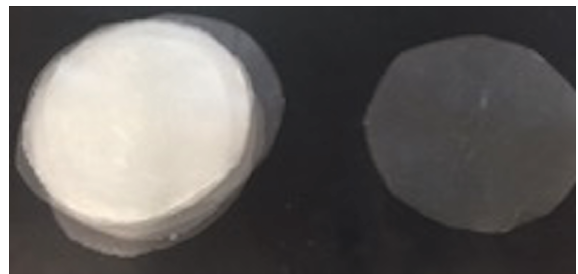
Figure 1: Fabricated polyurethane test films. Table 1: Radiation sources and corresponding dose rates. Age of source (# of